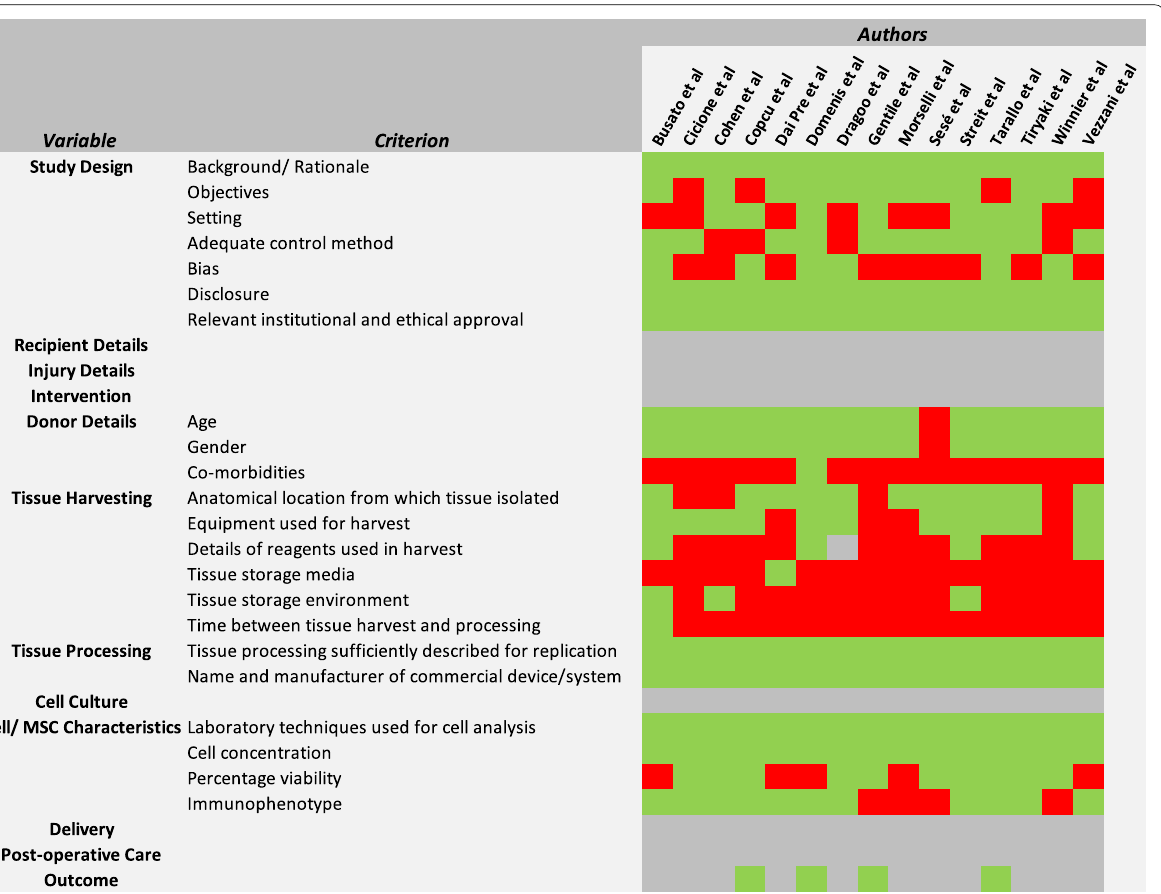
Fig. 3 Modified MIBO checklist for the assessment of methodological quality of included studies, with adaptations from the STROBE assessment tool: Heat map of reporting (Green- Adequate reporting of variables, Red- Inadequate or unreported, Grey- Variables not applicable to individual